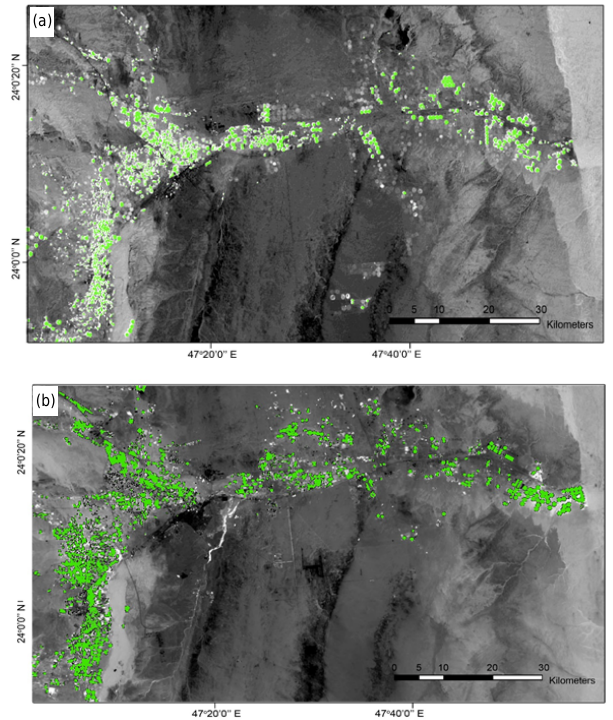
Figure 3. NDVI classification for Landsat satellite images of Al- Kharj from (a) 1987 and (b)